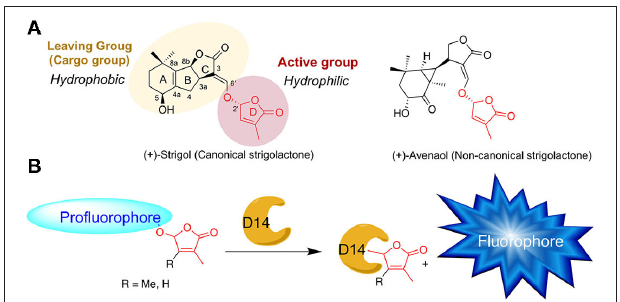
FIGURE 1 | (A) Chemical structures of natural strigolactones. (B) Principle of SL profluorescent probes. D14 = SL receptor.